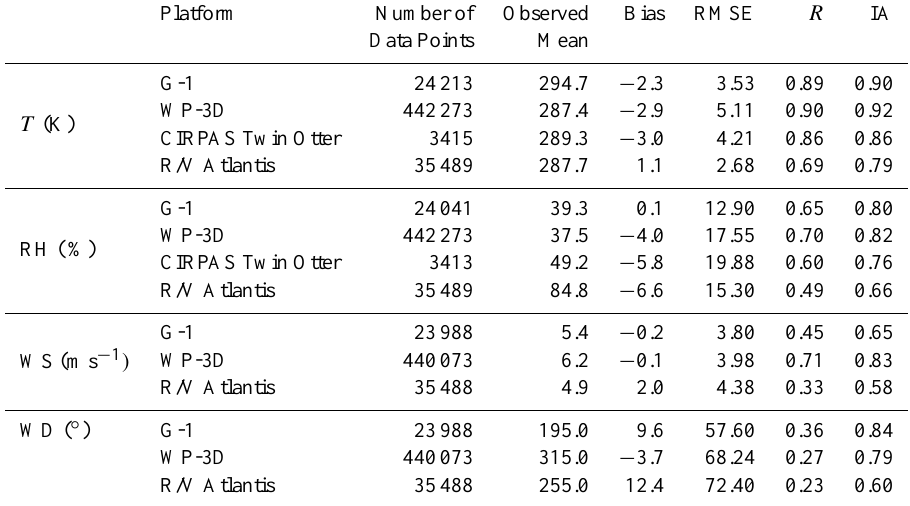
Table 5. Performance of simulated temperature (T), relative humidity (RH), wind speed (WS), and wind direction (WD) in terms of bias, root-mean-square error (RMSE), correlation coefficient ( R ), and index of agreement (IA) for all of the aircraft flight paths and ship